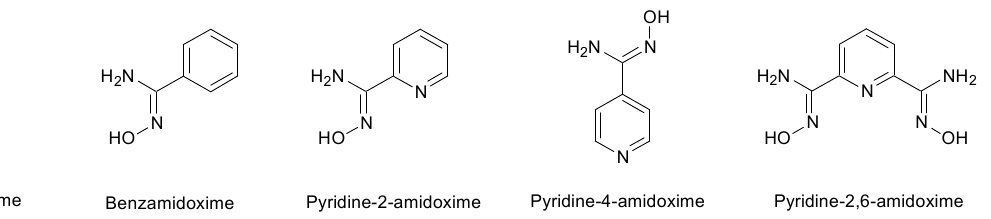
Figure 6. Amidoximes releasing NO in the presence of K 3 Fe[(CN) 6 ].